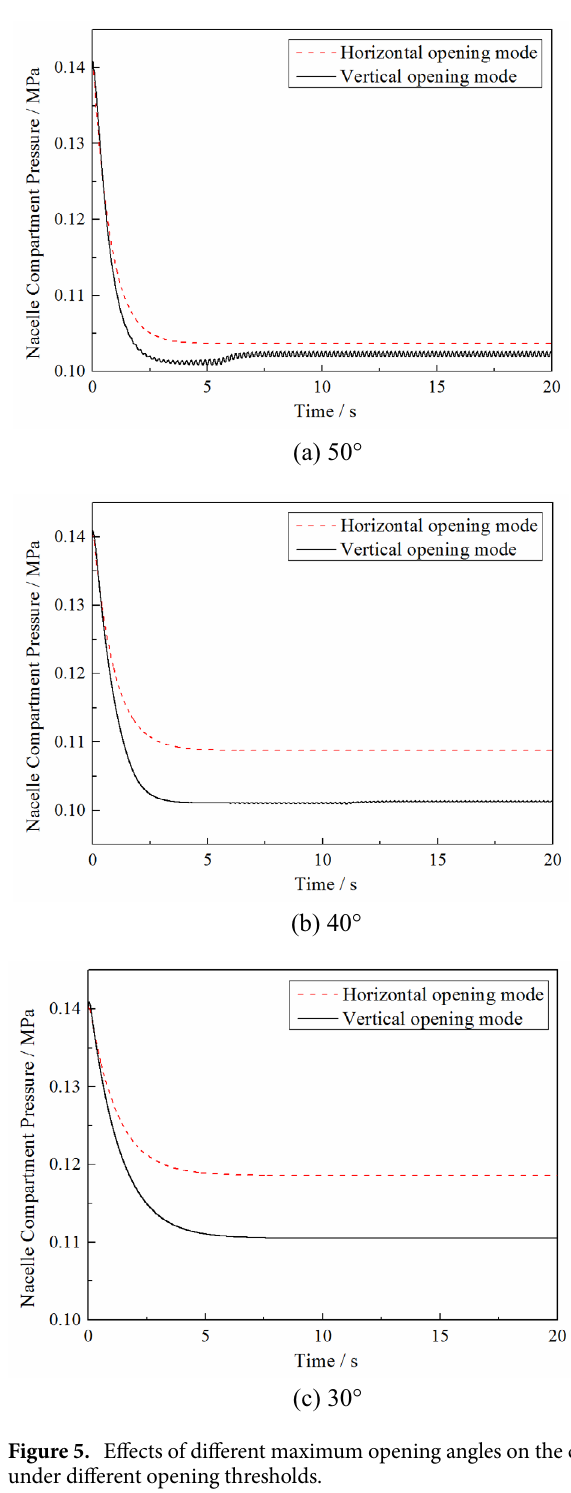
Figure 5. Effects of different maximum opening angles on the changes of the nacelle compartment pressure under different opening